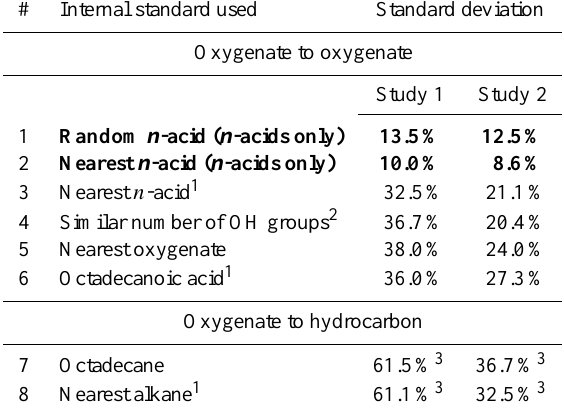
Fig. 4 are represented: correction of a hydrocarbon using a hydrocarbon of similar volatility (Fig. 5a: hexadecane cor- rected using hexadecane–d 34 ) , correction of an oxygenate us- ing an oxygenate of similar functionality (Fig. 5b: ketopinic acid, a mono-carboxylic acid, biogenic oxidation product corrected using tetradecanoic acid–d 27 ) , and correction of an oxygenate (alkanoic acid) using a nearly identical oxygenate (Fig. 5c: tridecanoic acid corrected using tetradecanoic acid– d 27 ; Fig. 5d: erythritol corrected using pentaerythritol–2- 13